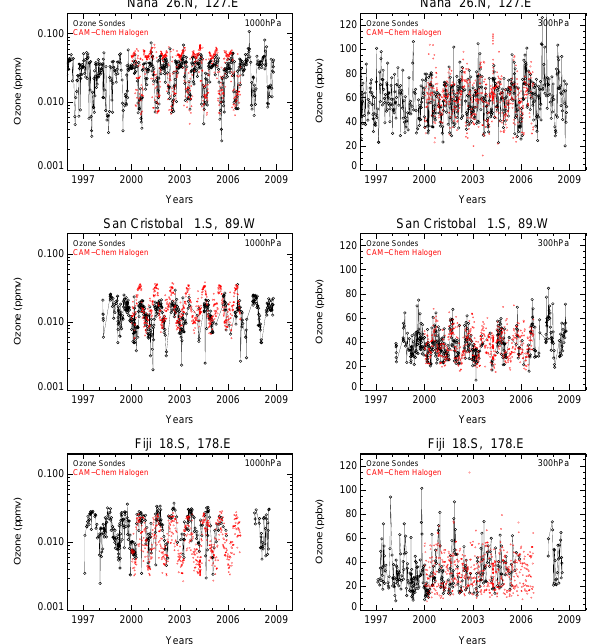
Fig. 4. Time series of observed and modelled ozone at (left) 1000hPa and (right) 300hPa for the location of three ozonesonde sites in the proximity of the tropics. A logarithmic vertical scale has been used for the 1000hPa time series to draw attention to the low ozone events. The time frequency is of around 30–40 observations per year and every 10 days for modelled